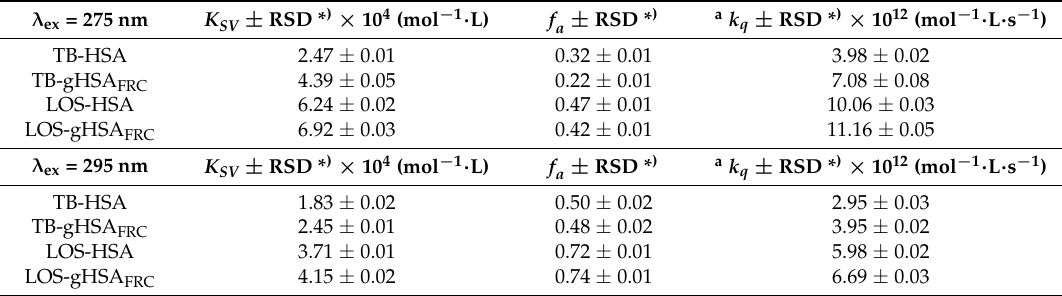
* ) relative standard deviation; a calculated using: 𝑘 𝑞 = 𝐾 𝑆𝑉 , where: τ 0 = 6.2 × 10 −9 s [19]—the average 𝜏 0 fluorescence lifetime of albumin without of quencher. Table 4. Stern-Volmer constants 𝐾 𝑆𝑉 (mol −1 ∙L), fractional accessible protein fluorescence 𝑓 𝑎 and biomolecular quenching rate constant 𝑘 𝑞 (mol −1 ∙L∙s −1 ) calculated for the ternary system: TB-LOS (const) - Table 4. Stern-Volmer constants K SV (mol − 1 · L), fractional accessible protein fluoresce f a and HSA, TB-LOS (const) -gHSA FRC , LOS-TB (const) -HSA, LOS-TB (const) -gHSA FRC ; λ ex = 275 nm and λ ex = 295 nm.